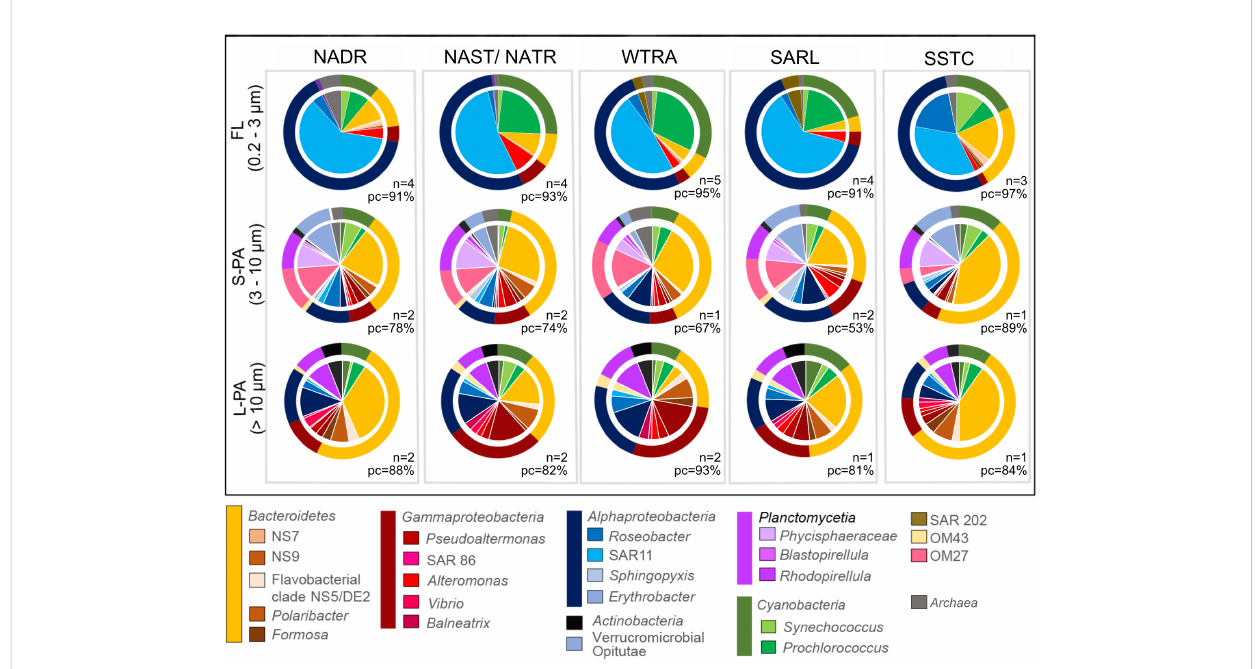
FIGURE 5 Pie chart of total bacterial cellular abundances counted using speci fi c CARD-FISH probes (Supplement Table 2) during the AMT22 cruise in 2012. The abundance of representative stations was averaged from multiple samples for each region. All fi sh data is available in Pangaea. The outer rings of the chart indicate the bacterial phylum, and the inner part indicates the taxon to genus level where determined. The samples were taken across fi ve regions, NADR North Atlantic Drift, NAST North Atlantic Subtropical, NATR North Atlantic Tropical Gyre, WTRA Western Tropical Atlantic, SATL South Atlantic Gyre, and SSTC South Subtropical Convergence, and fractionated into a free-living (FL), small particle-attached (S-PA) and large particle-attached (L- PA) fraction. n number of stations, PC probe coverage of total bacterial cell counts